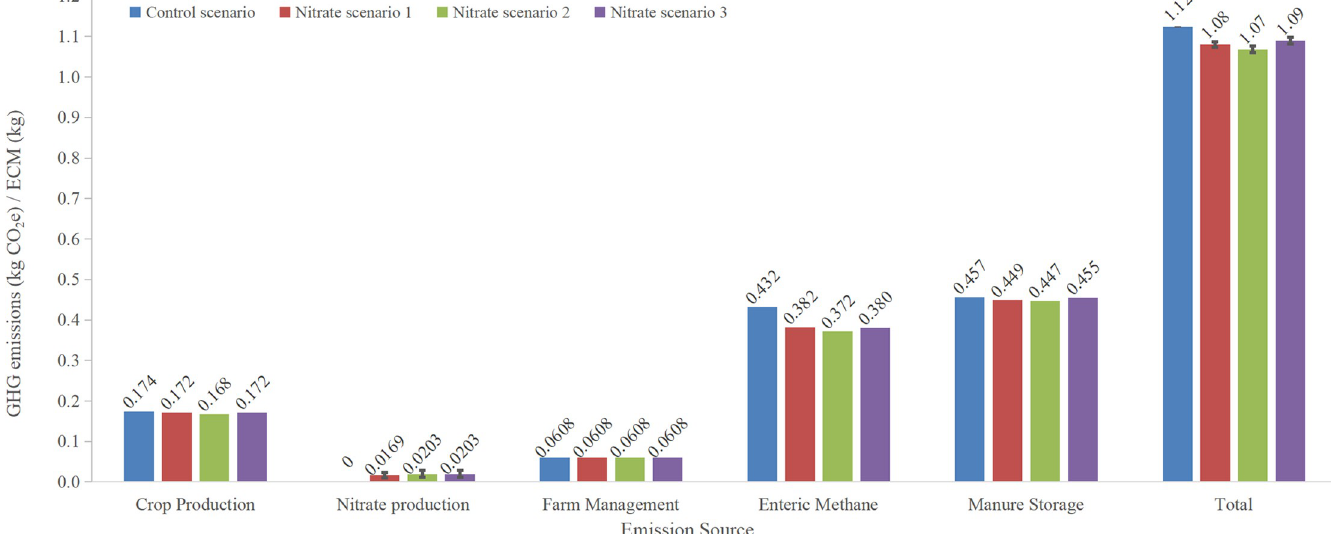
Fig 3. Comparison of global warming potential (GWP) by emission source for control and nitrate scenarios of dairy cows in California.